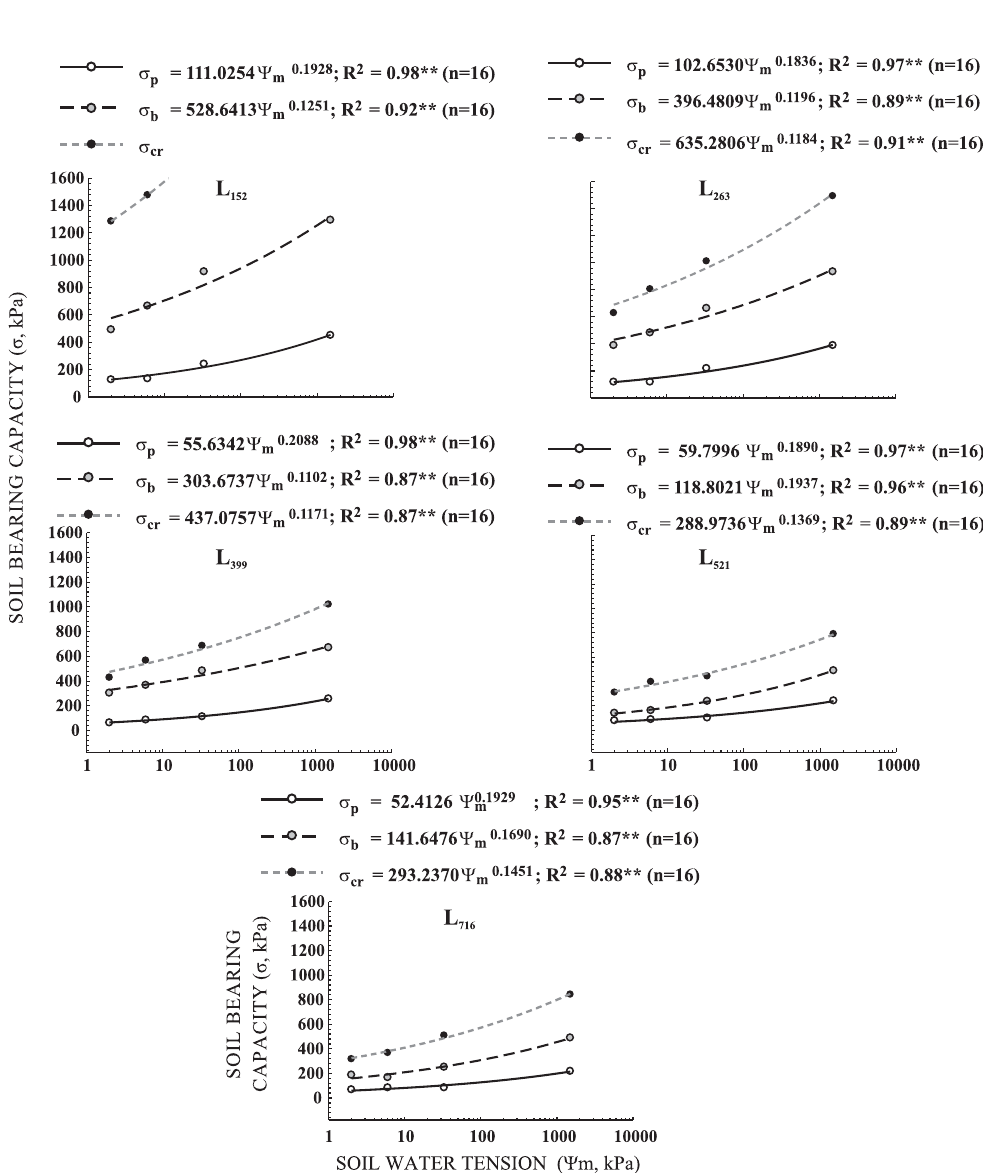
Figure 5. Soil bearing capacity models for additional compaction ( σσσσσ retention ( σσσσσ ) and critical for the reduction of soil macroporosity to 0.10 dm 3 dm -3 ( σσσσσ b in the county of Rio Verde,